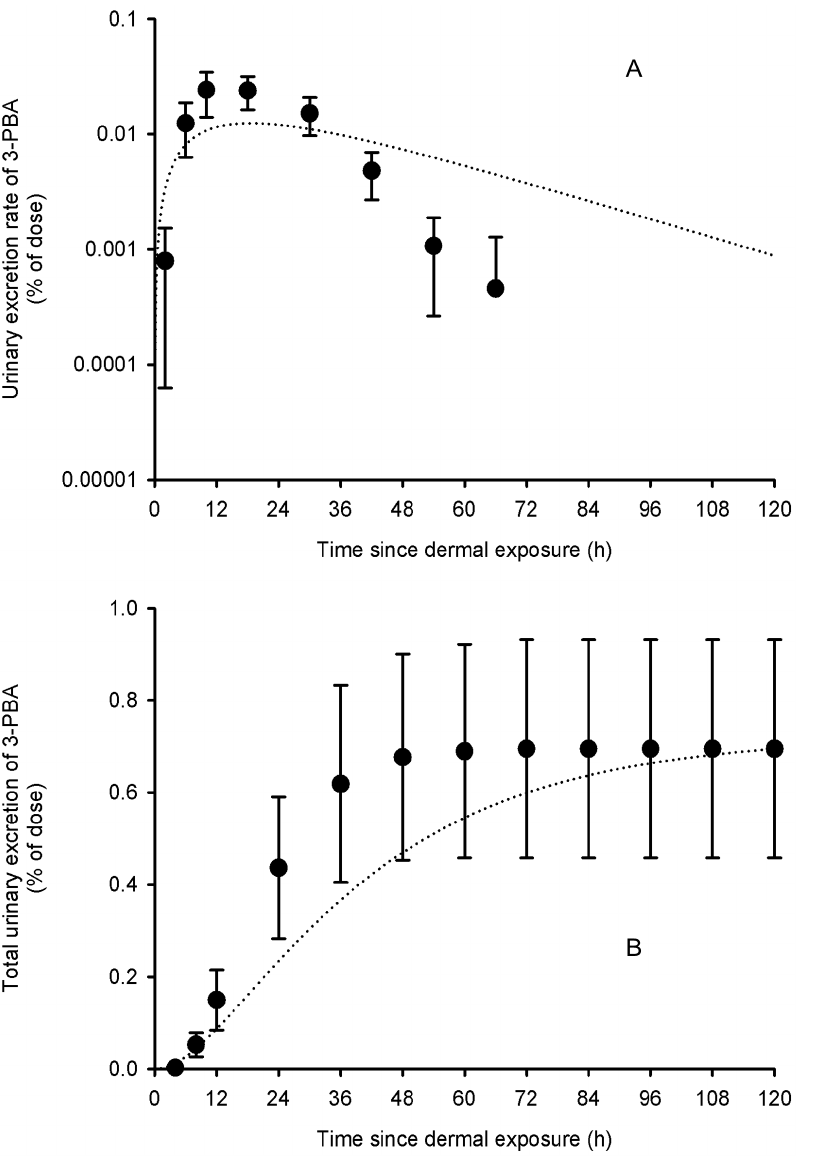
Figure 6. Comparison of model simulations with experimental data for 3-PBA (volunteers dermally exposed). Comparison of model simulations (lines) with experimental data of Woollen et al. (1992) (symbols) on the average time courses of 3-PBA excretion rate (A) and cumulative excretion (B) (% of applied dose) in volunteers dermally exposed to 31 mg of cypermethrin. Symbols represent average experimental values and vertical bars the experimental standard deviation (n=6). PBA represent 0.12, 0.23 and 0.16% of exposure dose (11.9, 23.1